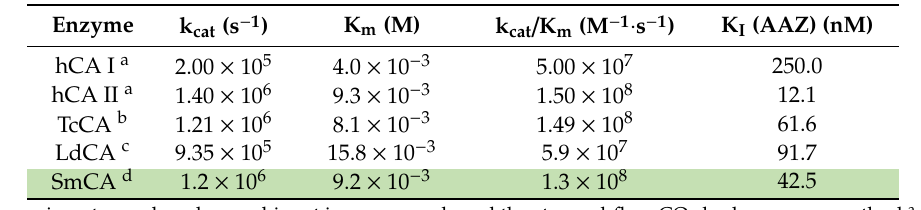
Table 1. Kinetic parameters for the CO 2 hydration reaction catalyzed by platyhelminth SmCA (green row) as well as the α -CA isozymes of human (h) hCA I and hCA II, protozoan Trypanosoma cruzi enzyme (TcCA) and Leishmania donovani (LdCA) at 20 ◦ C, pH 7.5 (for the α -CAs) and pH 8.4 (for the β -CA). Inhibition data (K I values) generated with the clinically used drug Acetazolamide ( AAZ